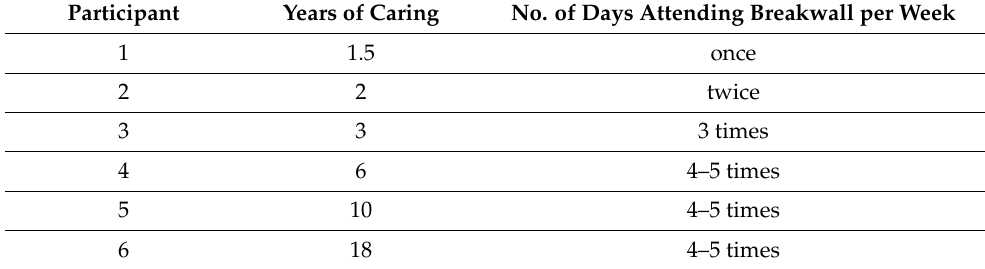
Table 1. Participant demographics; Stockton Breakwall Cat Caretakers.